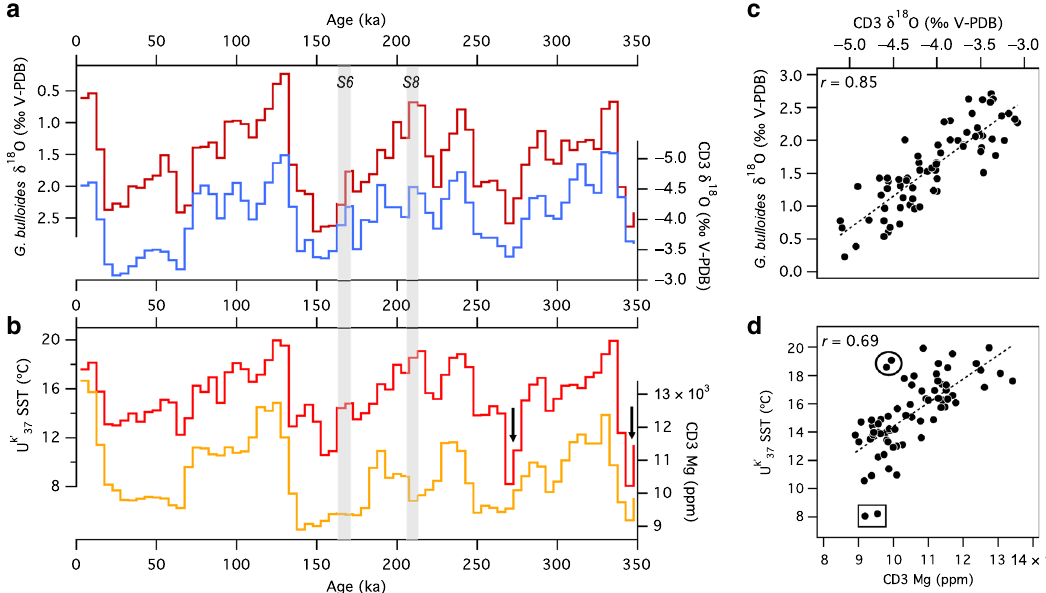
Fig. 3 CD3-1 and ocean-core data for the last 350,000 years. a Synchronization of the CD3-1 δ 18 O series (blue) to the planktic foraminiferal δ 18 O from G. bulloides (crimson) from sites MD01-2443/2444 (see ‘ Methods ’ and Supplementary Fig. 3). b CD3-1 Mg (orange) compared to the alkenone U k ’ surface temperatures (SST) from sites MD01-2443/2444 (red). The Mg captures much of the orbital-scale variation in the SST. Grey vertical bands are the position of sapropel events S6 and S8, whose ages are based on the adjusted CD3-1 chronology. c , d Correlations arising directly from the synchronization between CD3-1 δ 18 O and planktic δ 18 O a , and between CD3-1 Mg and SST shown in b . Black circle and square in d highlight outlier points discussed in the text. Black arrows in b indicate intervals where exceptionally low SSTs are not matched by correspondingly low Mg concentrations. All series have been resampled at 5 kyr resolution (see ‘ Methods ’